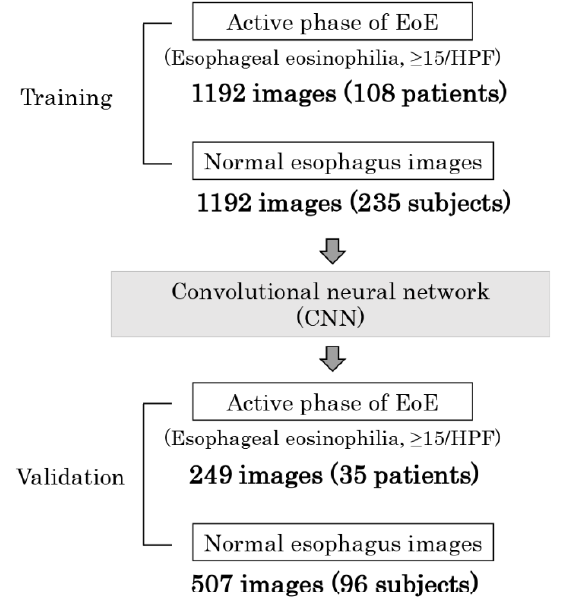
Figure 1. Flow diagram of CNN learning.